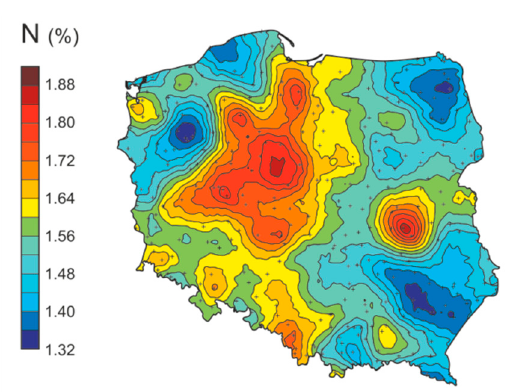
Figure 3. Spatial pattern of atmospheric nitrogen deposition in Poland, based on the concentration of nitrogen in Pleurozium schreberi (adapted from [12]).